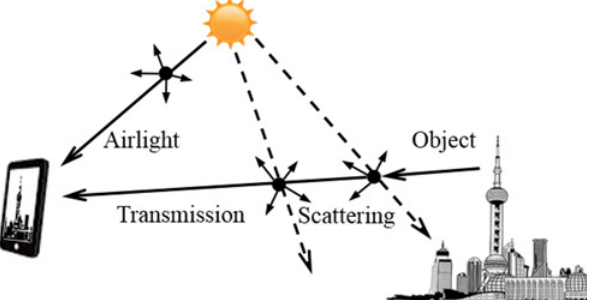
Fig 1. The radiance reaching the smartphone camera is the summation of the transmitted light from the object and airlight from the sun after scattering by air, water and PM in atmosphere.